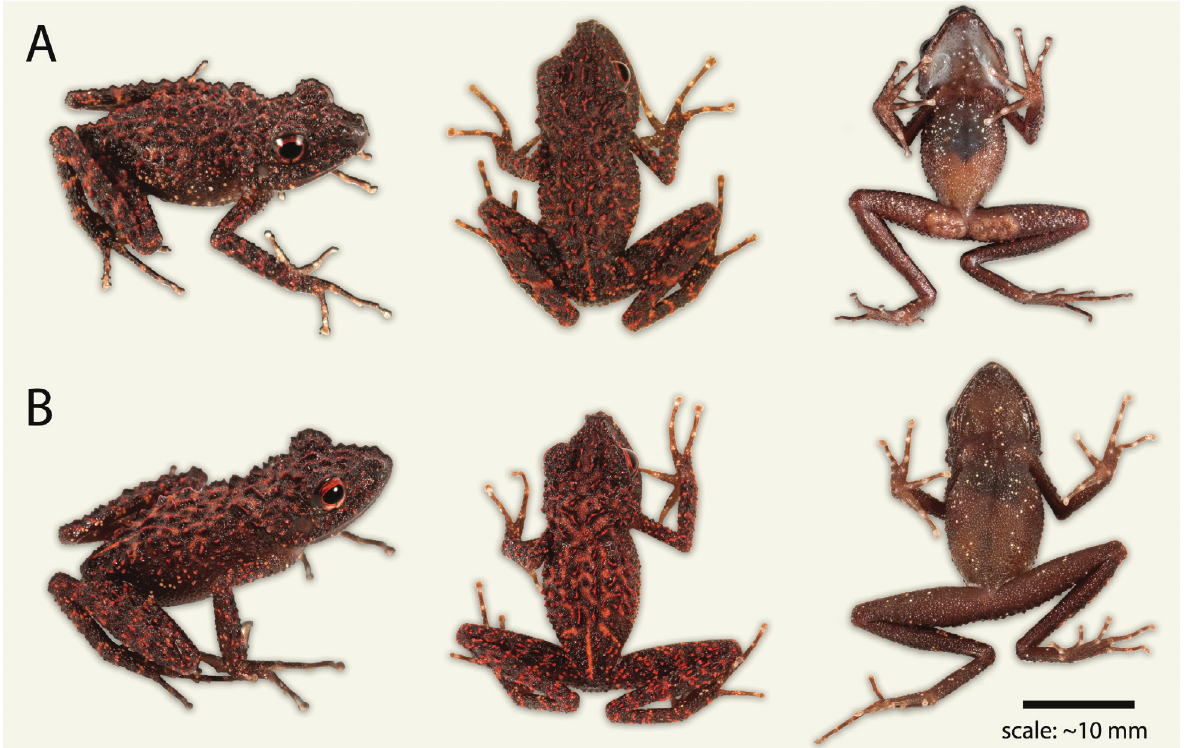
Figure 2. Ex-situ dorsal-lateral, dorsal and ventral photographs of A. Male Gephyromantis marokoroko sp. nov. (holotype, KU 343230) and B. Female (paratype, KU 343218) in